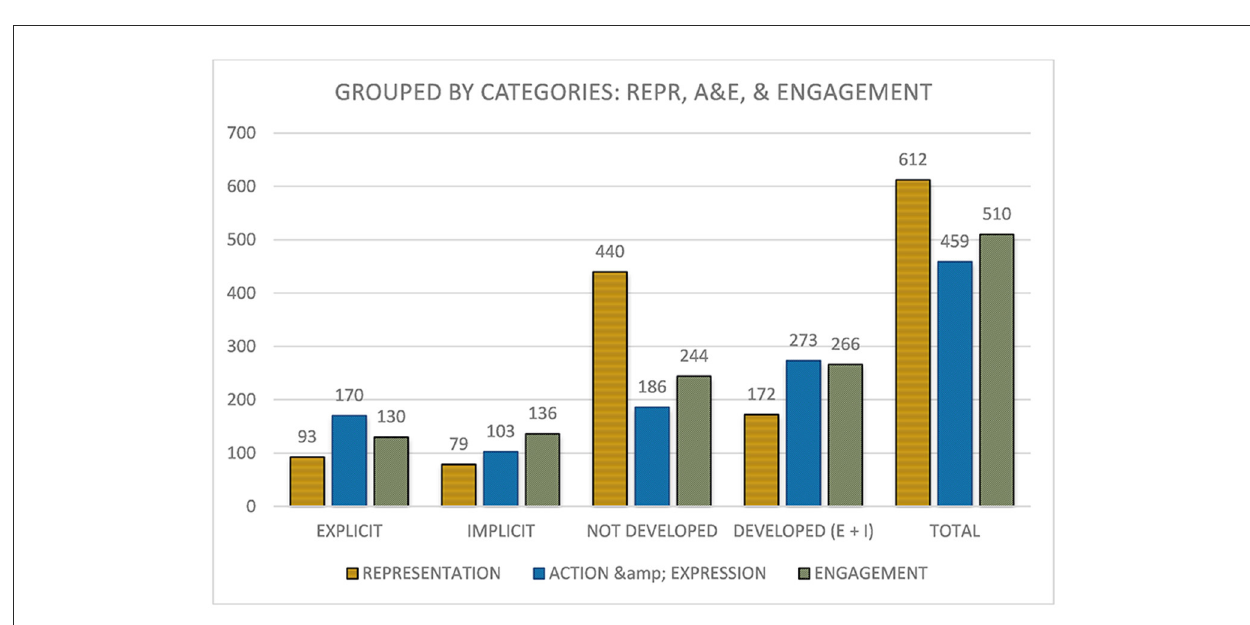
FIGURE3 Identified uses of checkpoints grouped by the three